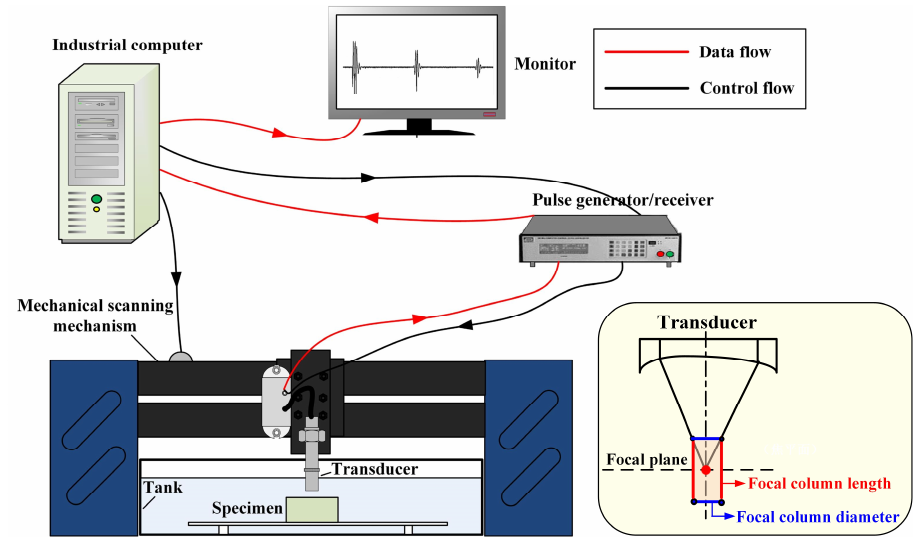
Figure 2. The diagram of ultrasound microscope working principle.